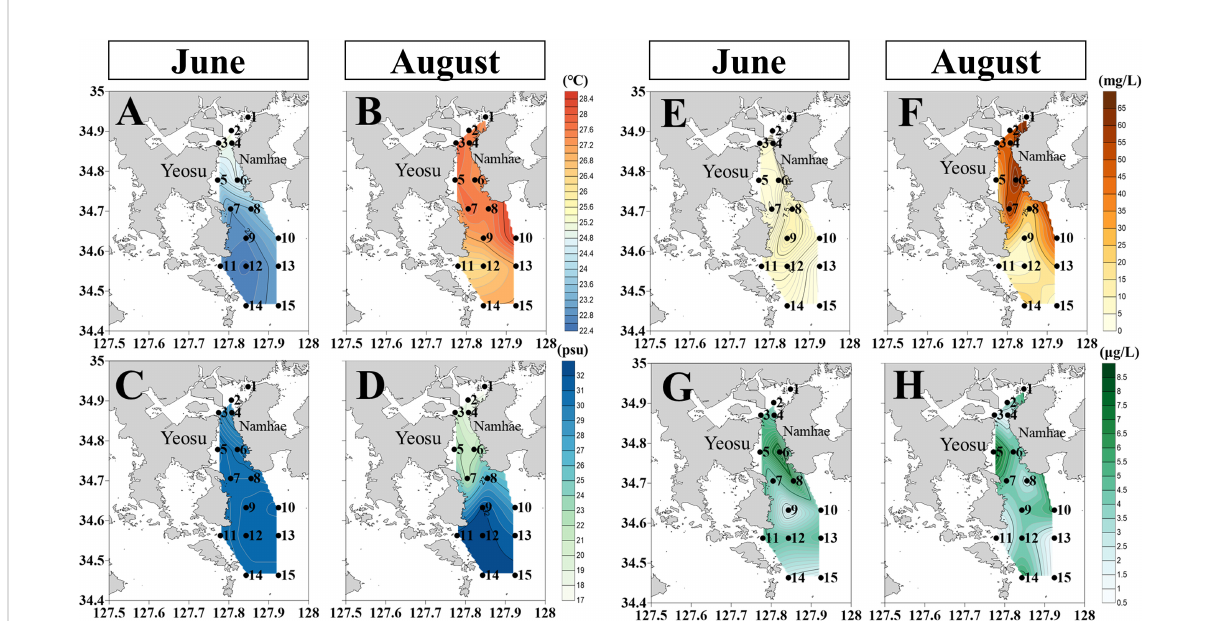
FIGURE 2 Horizontal distribution of environmental variables in June and August 2018. Sea surface temperature during June (A) and August (B) . Surface salinity during June (C) and August (D) . SPM during June (E) and August (F) . Chlorophyll – a concentration during June (G) and August (H) .